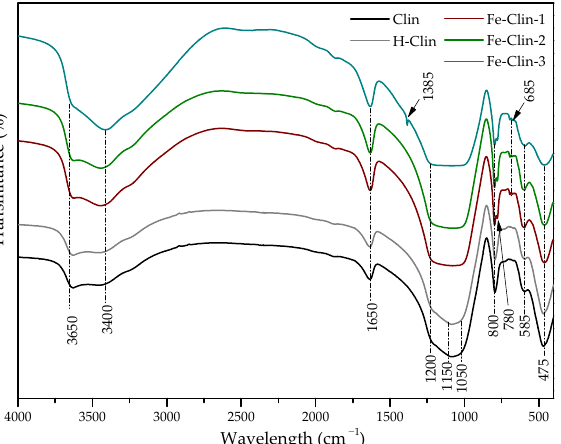
Figure 4. FT-IR spectra of raw clinoptilolite (Clin), protonated clinoptilolite (H-Clin), and clinoptilo- lite modified with different Fe contents (Fe-Clin-1, Fe-Clin-2, Fe-Clin-3).